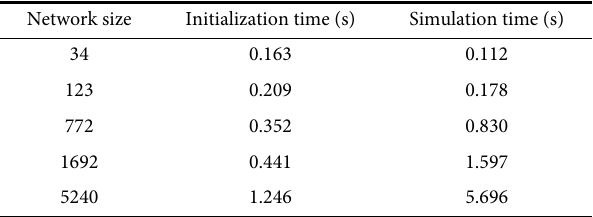
Table 2 Simulation time of network models with different sizes